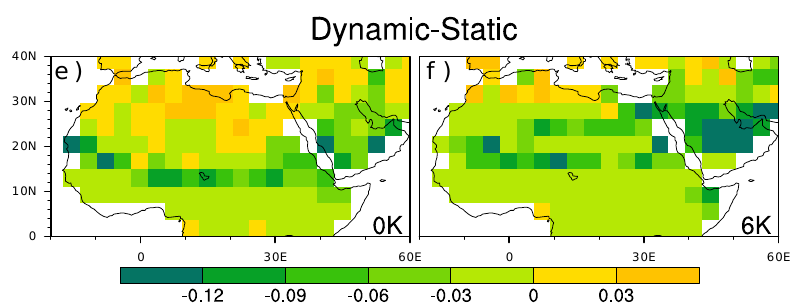
Fig. 3. Desert fraction (DF) averaged over 100 years for (a) 0K st, (b) 0K dyn, (c) 6K st, (d) 6K dyn. 100-year mean desert fraction differences between (e) 0K dyn and 0K st, (f) 6K dyn and 6K